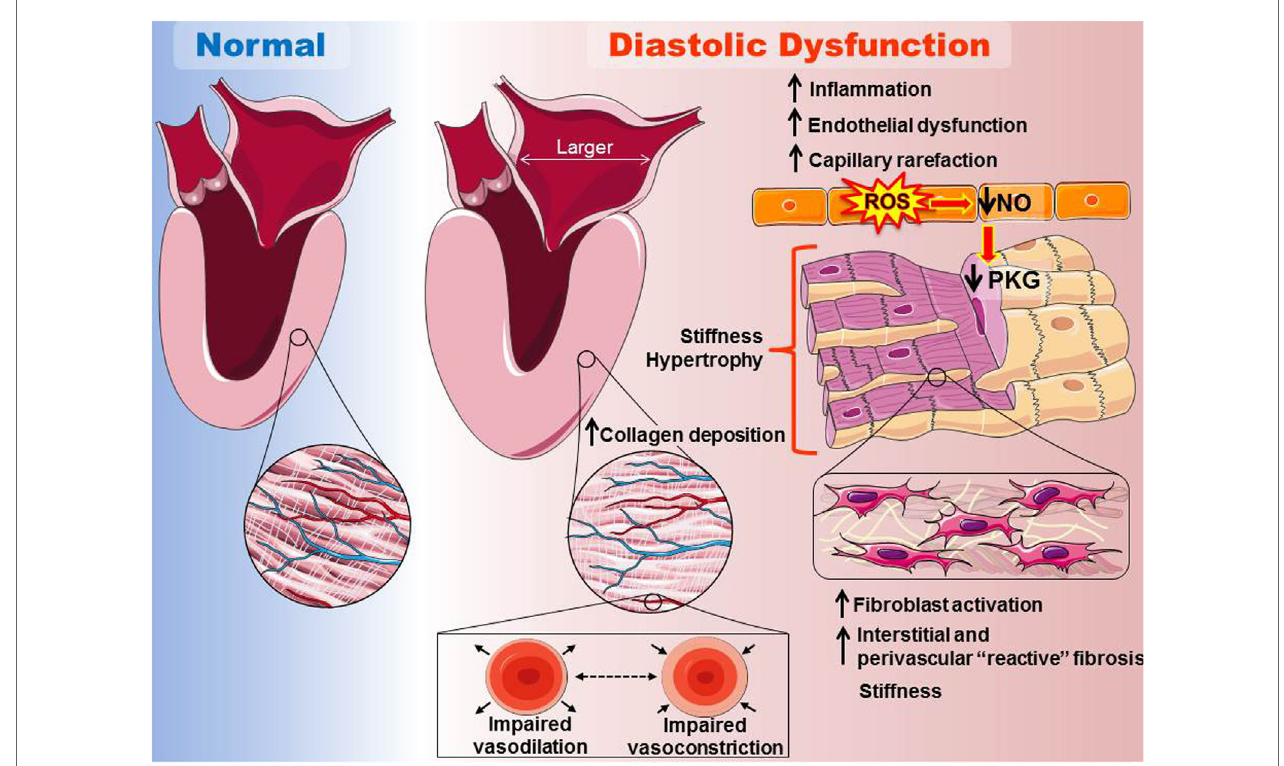
FiGURe 2 | Scheme for the proposed etiology of heart failure with preserved ejection fraction (HFpEF) relevant to obesity and type 2 diabetes. Left side: at the organ level, HFpEF is characterized by cardiac hypertrophy and a marked increase in the left ventricular mass/volume ratio (concentric remodeling), as well as increased stiffness and often enlargement of the left atrium. Right panel: coronary microvascular inflammation is postulated to play a key role in HFpEF progression, encompassing endothelial dysfunction and reduced nitric oxide (NO)-cyclic guanosine monophosphate (cGMP)—protein kinase G (PKG) signaling. Increased stiffness of both myofilaments and the extracellular matrix is thought to impair diastolic function of the heart. The former is postulated to result in part from reduced PKG-mediated phosphorylation of titin, the protein that determines passive elasticity of cardiomyocytes. The later would result from increased collagen deposition and cross-linking (fibrosis), due to loss of cGMP/PKG anti-fibrotic signaling and increased inflammatory endothelium-mediated recruitment of immune cells that activate resident cardiac fibroblasts. Diastolic dysfunction is likely an antecedent event that interacts synergistically with other remodeling events at the cellular level to foster development of HFpEF (images adapted and reproduced with permission from the copyright holder